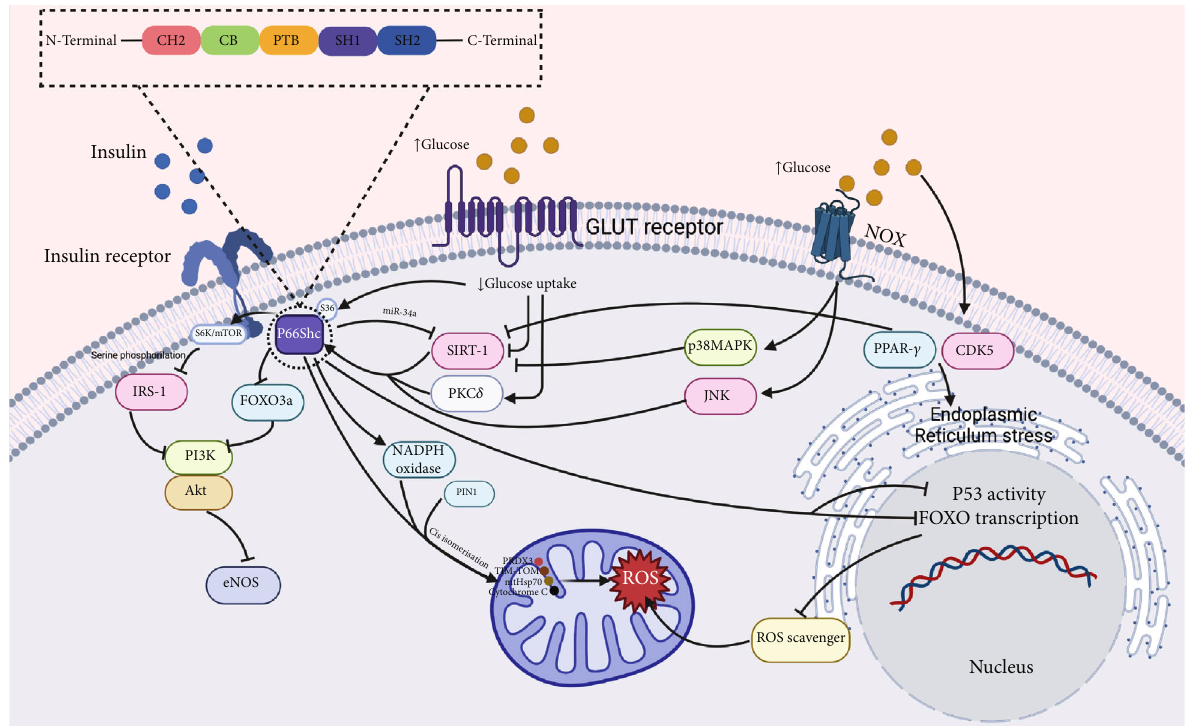
Figure 1: A summary of molecular pathways related to p66Shc and